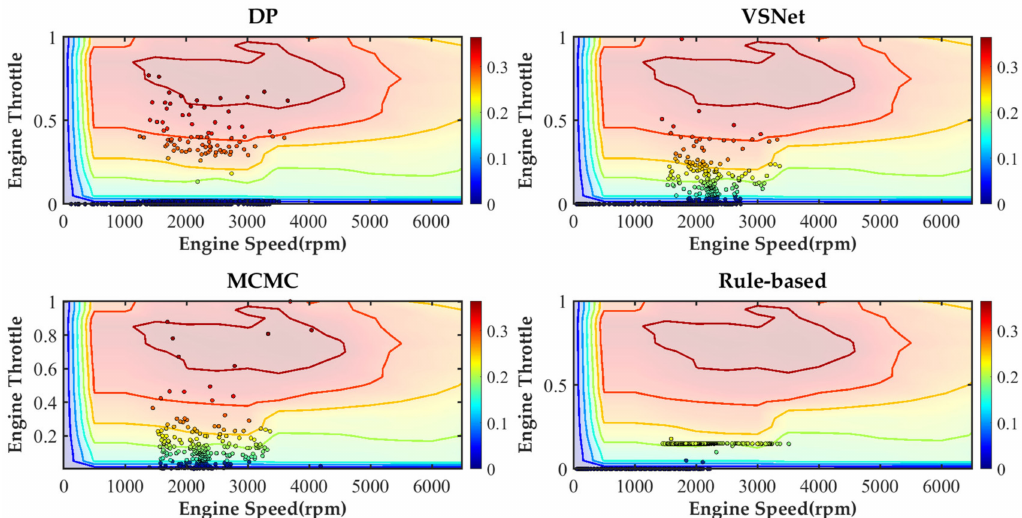
Figure 22. The distribution of engine operating points under various